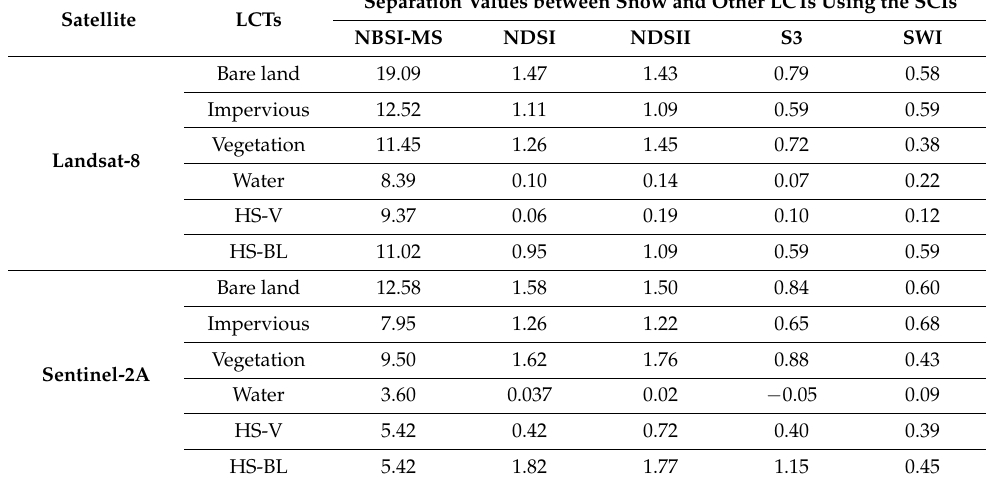
Table 10. The Snow-Cover Indices (SCIs) Separation values between snow and Land Cover Types (LCTs) in the France–Italy region using the Landsat 8 OLI and Sentinel-2A MSI datasets. Separation Values between Snow and Other LCTs Using the SCIs Satellite LCTs